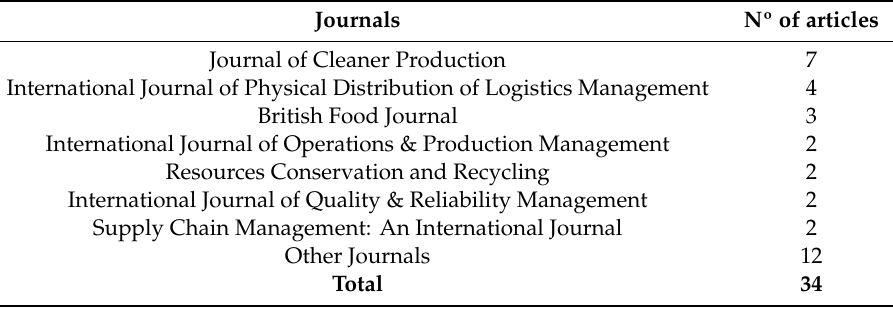
Table 2. Distribution of articles on the publication of journals.